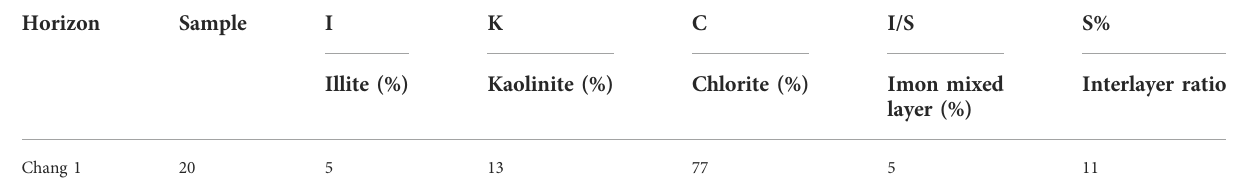
TABLE 1 Statistical results of X-diffraction data of clay minerals in the target sandstones.